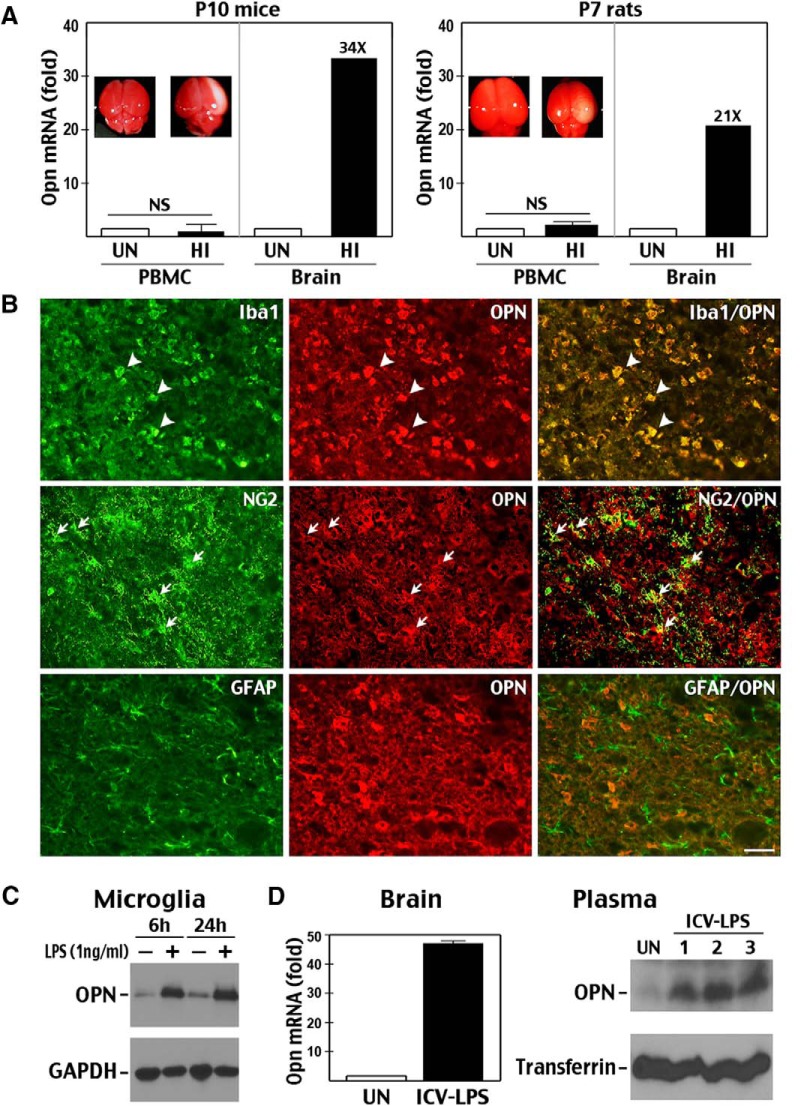
Source and specificity of plasma OPN as a biomarker. A, RT-PCR showed that HI triggered a 20- to 30-fold increase of Opn mRNA in the brain of P10 mice and P7 rats at 24-h recovery, but only insignificant changes in PBMCs (n = 4–5 for each group). B, Immunolabeling showed widespread OPN expression by Iba1+ microglia and occasional expression in NG2+ glial progenitors, but rare expression in GFAP+ astrocytes after HI injury (n > 4). Scale bar: 40 μm. C, Application of LPS (1 ng/ml) to microglial SM826 cells in vitro led to induction of OPN protein. D, Similarly, ICV injection of LPS (1 μg) induced Opn mRNA in brain as well as plasma OPN protein at 24-h recovery.